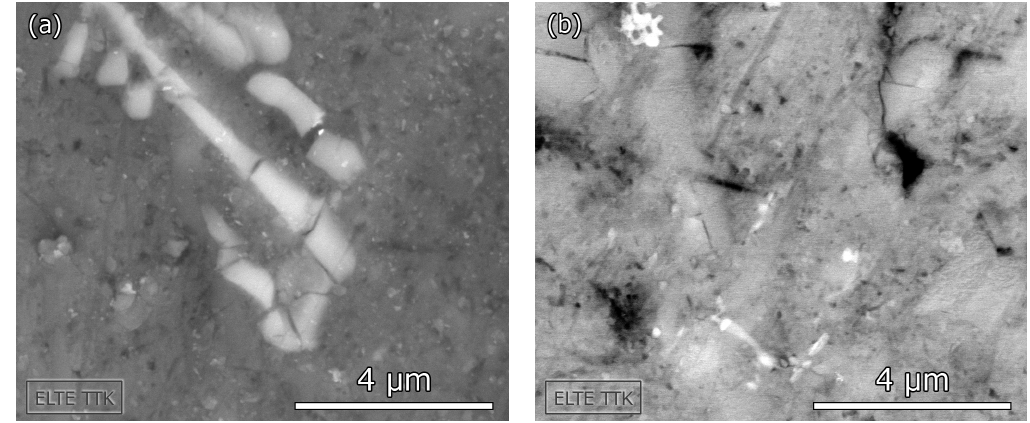
Figure 6. SEM images of the fractured brittle phases ( a ) Al-Si-Fe intermetallic phase; ( b ) Si